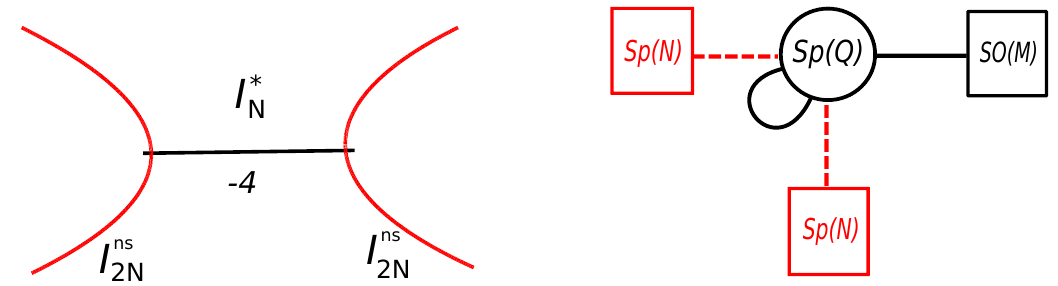
Figure 8. Left: schematic description of the geometry of the F-theory model correspoding to the 4 theory. Right: 2d quiver theory for a bound state of Q BPS strings, here M = 2 N +8 [73]. SO(2 N +8) O ( Q ) with an anti-symmetric multiplet as well as a bifundamental hypermultiplet carrying Sp( N ) (cid:13)avor symmetry. The D 0 (cid:13)avor defect on the other hand supports an SO(4 N +16) ortho-symplectic bifundamental (0 ; 4) Fermi multiplet, which couples to the Sp( N )